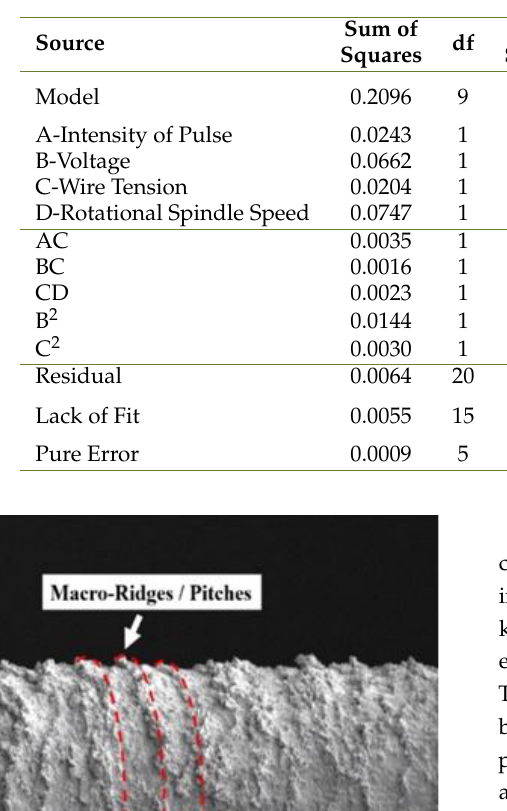
Table 4. ANOVA for the response of surface roughness - reduced quadratic model